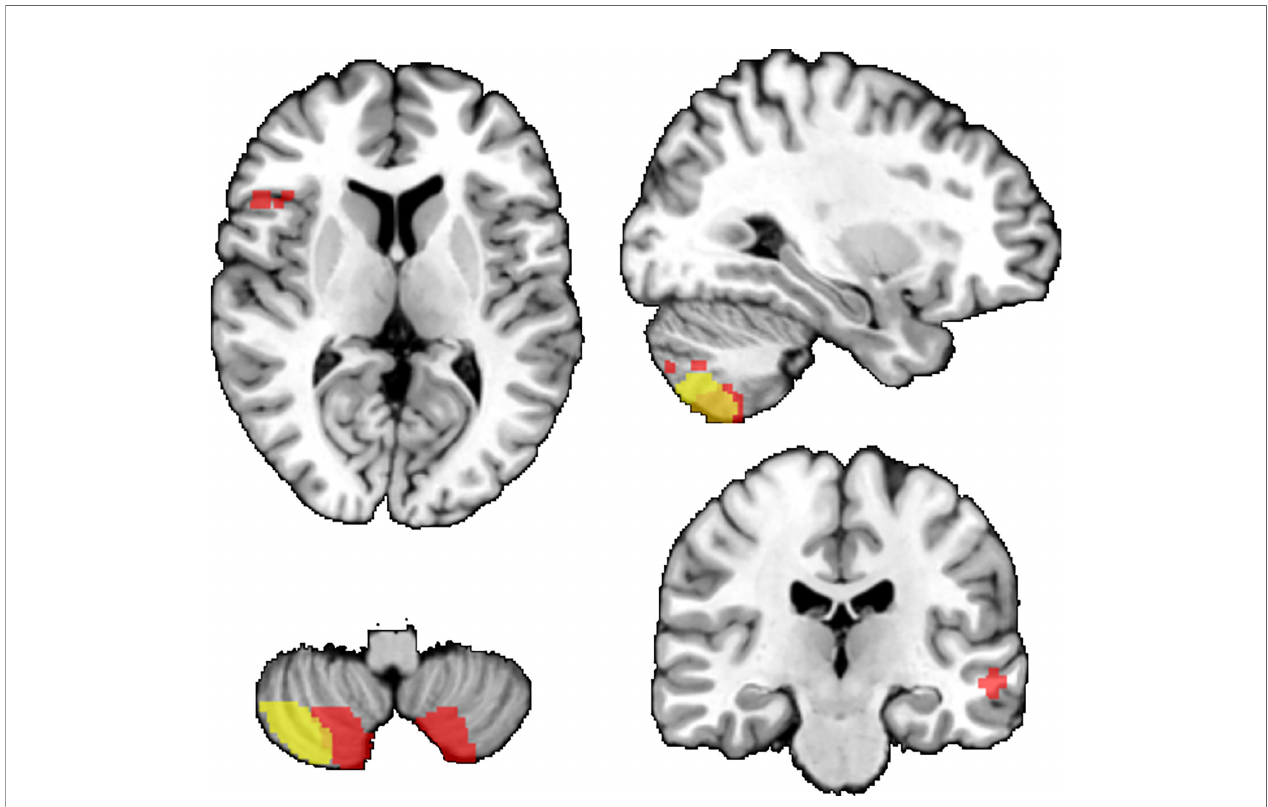
FIGURE 2 | Results of secondary VBM analyses (whole-brain). Brain regions where FEP had lower GM volumes than healthy participants (red). Negative associations between BMI and GM volumes (yellow). Overlap between the associations with FEP and BMI (orange). TFCE corr. p < 0.05. Results are displayed superimposed on the Colin 27 T1